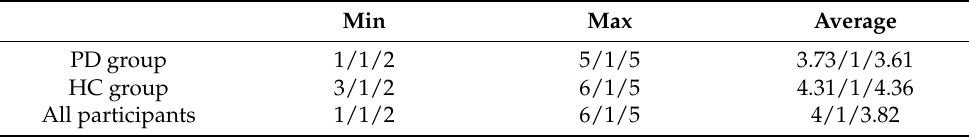
Table 5. Minimum, maximum and average number of segments (per group and